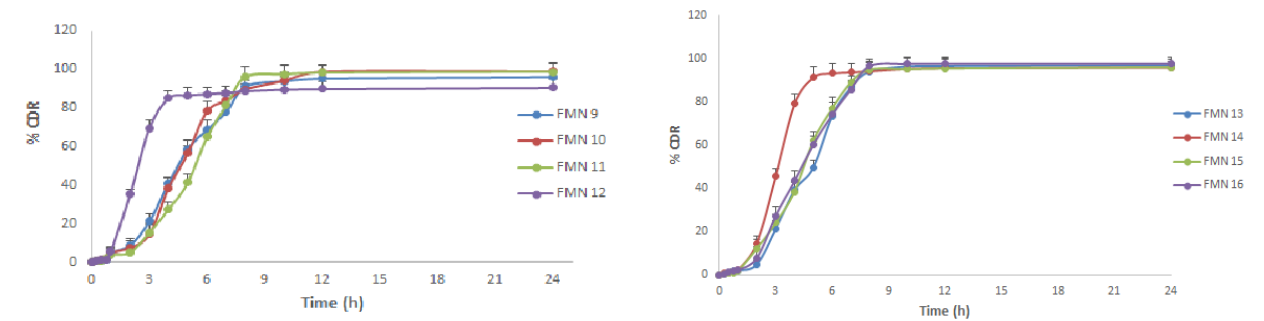
Figure 1(C) - IIn vitro release profile of formulation F9-F12. Figure 1(D) - In vitro release profile of formulation F13-F16.